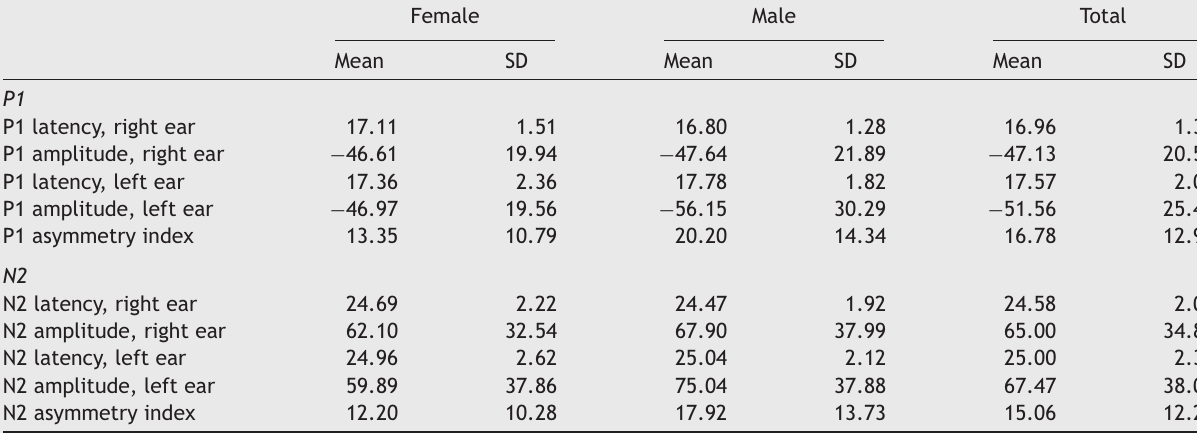
Mean values and standard deviations of cVEMP curve parameters in 30